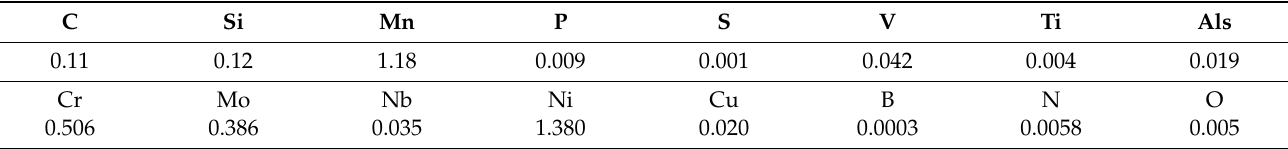
Table 1. Chemical composition of SXQ500/550DZ35 steel (Wt